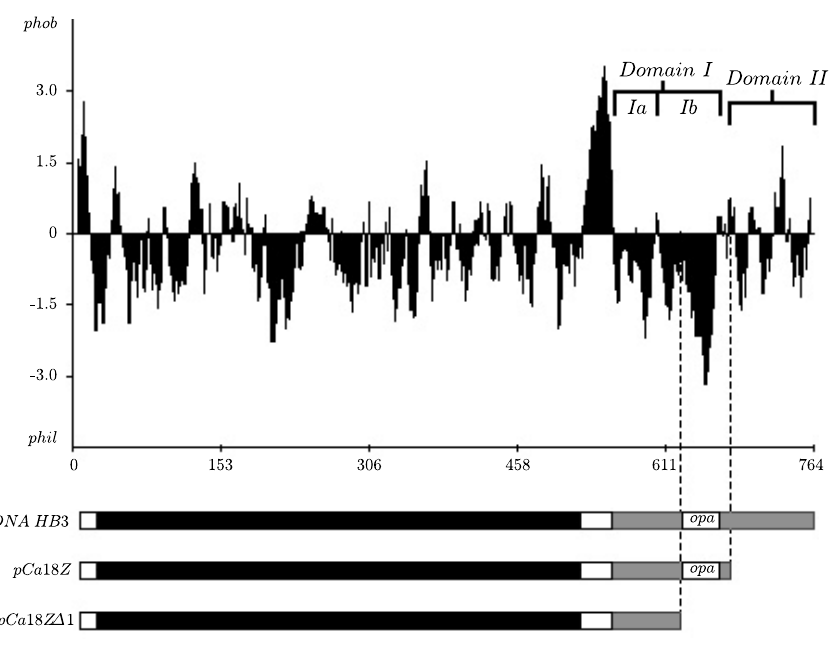
Fig. 1 – Structural organization of the complete Rst-IrreC protein and the truncated forms produced by the constructs tested in this work. A hydropathic profile of the Rst-IrreC protein is shown in the upper part of the figure. The intracellular subdomains and the opa region are indicated (see text for details). In the lower part, the boxes indicate how much of the wild type protein remains in the truncated products. White, signal peptide and transmembraned domains. Gray, intracellular domain: the approximate location of the opa-like sequence is shown. Black, extracellular